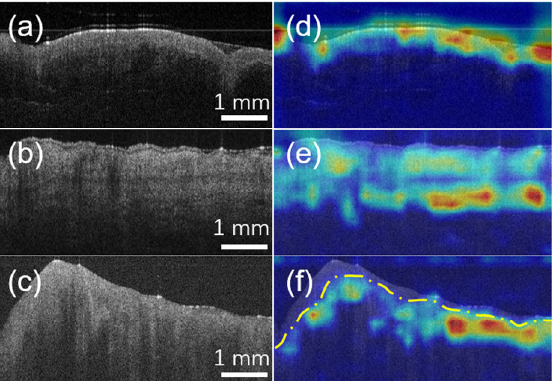
Figure 7. Visualization on OCT images of oral tissues using Grad-CAM. ( a – c ) are representative OCT images of normal mucosa, LEH, and OSCC, respectively. ( d – f ) are the corresponding activation maps with unique feature aggregations, respectively.